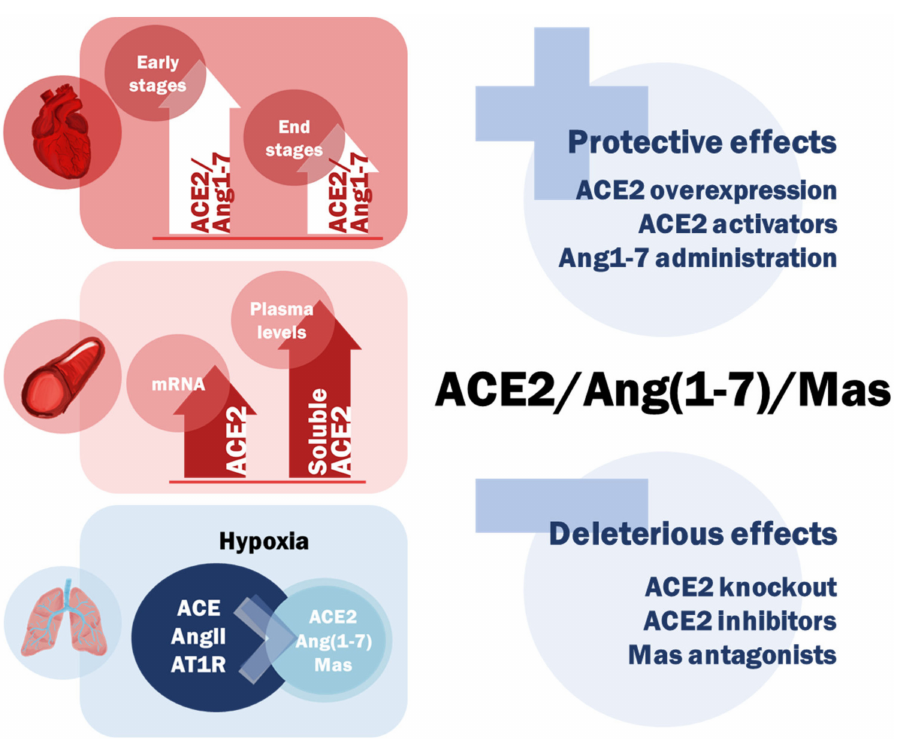
Figure 3. The main conclusions of the overall ACE2/Ang(1-7)/Mas axis activity in cardiovascular and pulmonary hypoxic